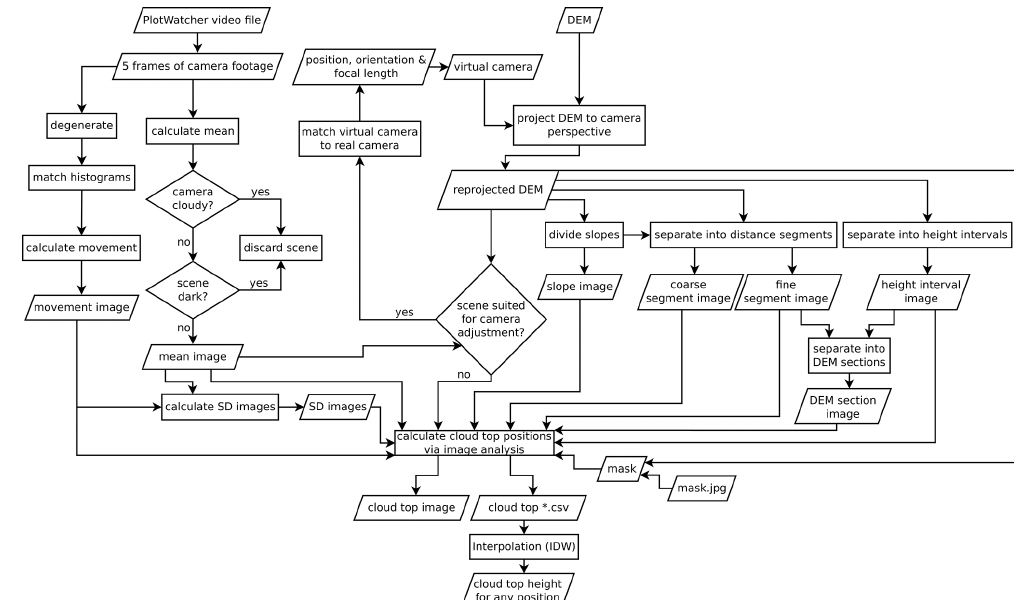
Figure 5. Workflow for the retrieval of z CT